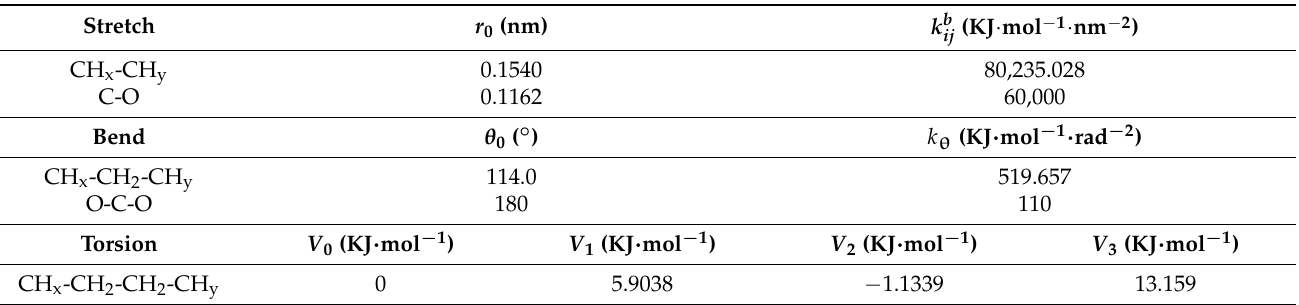
Table 2. Parameters for bonded interactions.